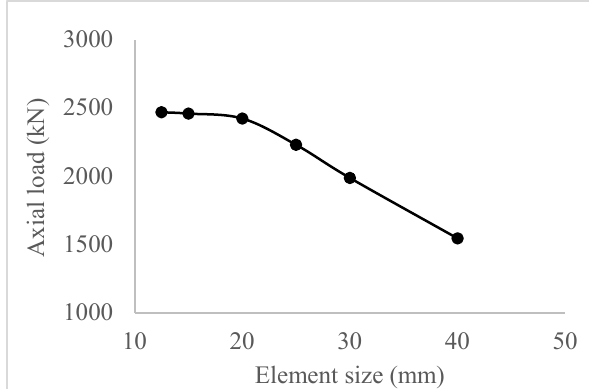
Figure 5. Mesh sensitivity analysis results.